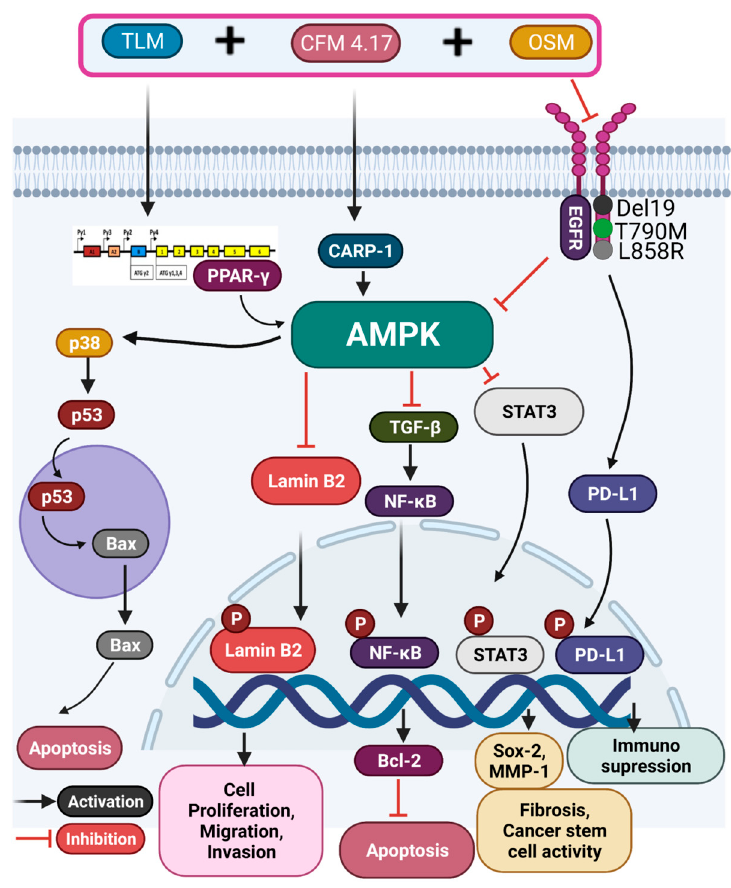
Figure 6. Plausible mechanism of action of CFM4.17, Telmisartan and Osimertinib combination against non-small cell lung cancers in athymic nude mice. Telmisartan activates the PPAR- γ nuclear receptor, CFM4.17 acts on CARP-1, and Osimertinib inhibits the EGFR mutated gene, increasing AMPK activity and thus regulating the p38 MAPkinase pathway, Lamin B2 protein, JAK-STAT path- way, PDL-1, and NF- κ B pathway to maintain apoptosis, cancer metastasis, and immune suppression. Bcl-2: B-cell lymphoma 2, Bax: BCL2-associated X protein, CARP-1: Cell cycle and apoptosis reg- ulatory protein 1, EGFR: epidermal growth factor receptor, CFM-F: lipid formulation of CFM4.17, MMP-1: Matrix metalloproteinase-1, OSM: Osimertinib, PD-L1: Programmed cell death 1 ligand 1, STAT3: Signal transducer and activator of transcription 3, SOX2: SRY-Box Transcription Factor 2, TLM: